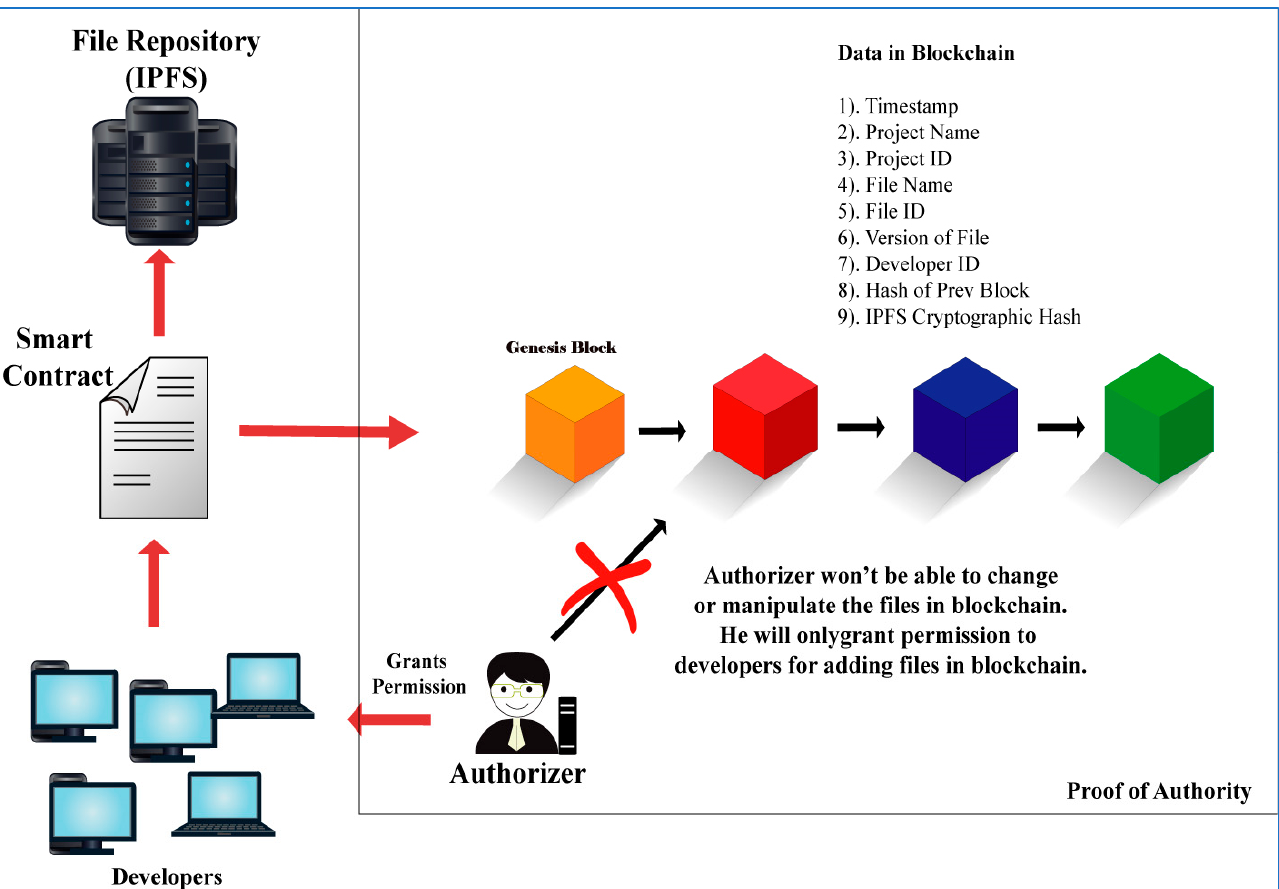
Figure 6. Proposed BDA-SCV Architecture.